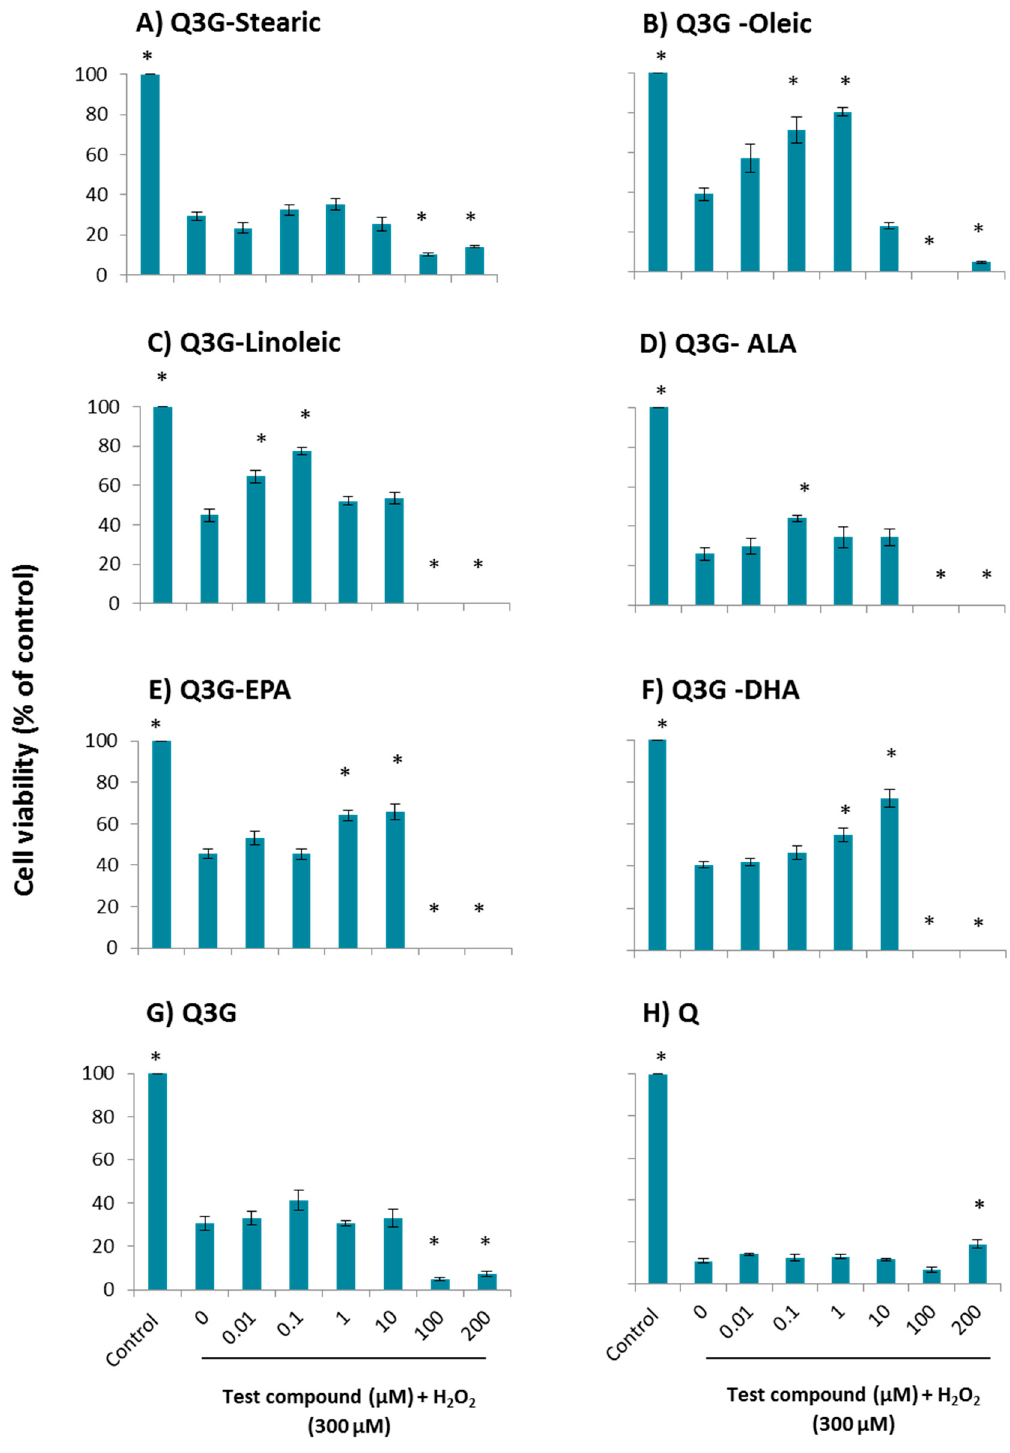
Figure 3. Dose-dependent cytoprotective effect of test compounds against H 2 O 2 -induced cytotoxicity in human primary hepatocytes. ( A ) Stearic acid ester of Q3G; ( B ) Oleic acid ester of Q3G; ( C ) Linoleic acid ester of Q3G; ( D ) ALA ester of Q3G; ( E ) EPA ester of Q3G; ( F ) DHA ester of Q3G; ( G ) Q3G and ( H ) Quercetin. Cells were pre-incubated for 48 h followed by incubation with 300 µM H 2 O 2 for 3 h. Cell viability is presented as percentage related to the control. Control contains cells with no incubation of test compounds and no oxidative injury. Data are expressed as mean ± SEM ( n = 6). * p ≤ 0.05, significantly different from model group. The cells in model group were subjected to oxidative injury by H 2 O 2 , but not treated with any test compounds.